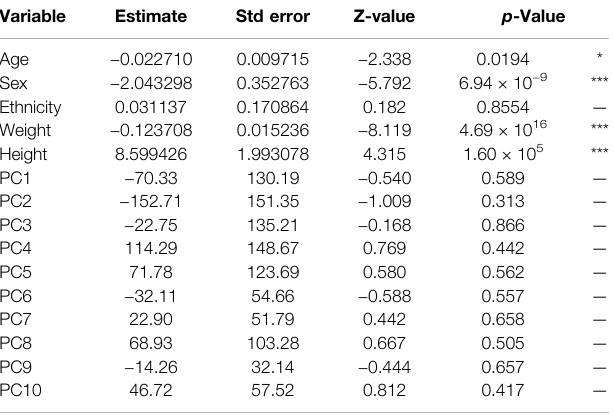
TABLE 2 | Generalized linear model (GLM) of case-control status against age, ethnicity, weight, height, sex, and principal components.